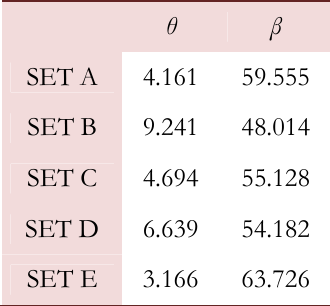
Table 5: Parameter θ and β of the Weibull two-parameter